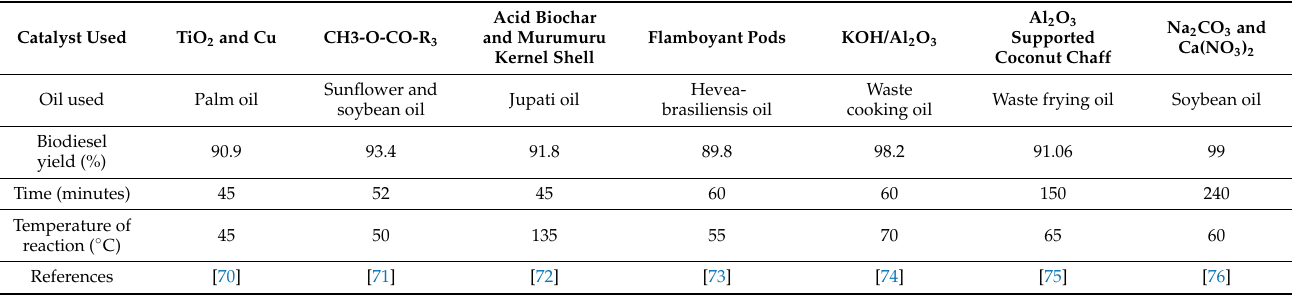
Table 3. Different researchers work on heterogeneous catalysts.